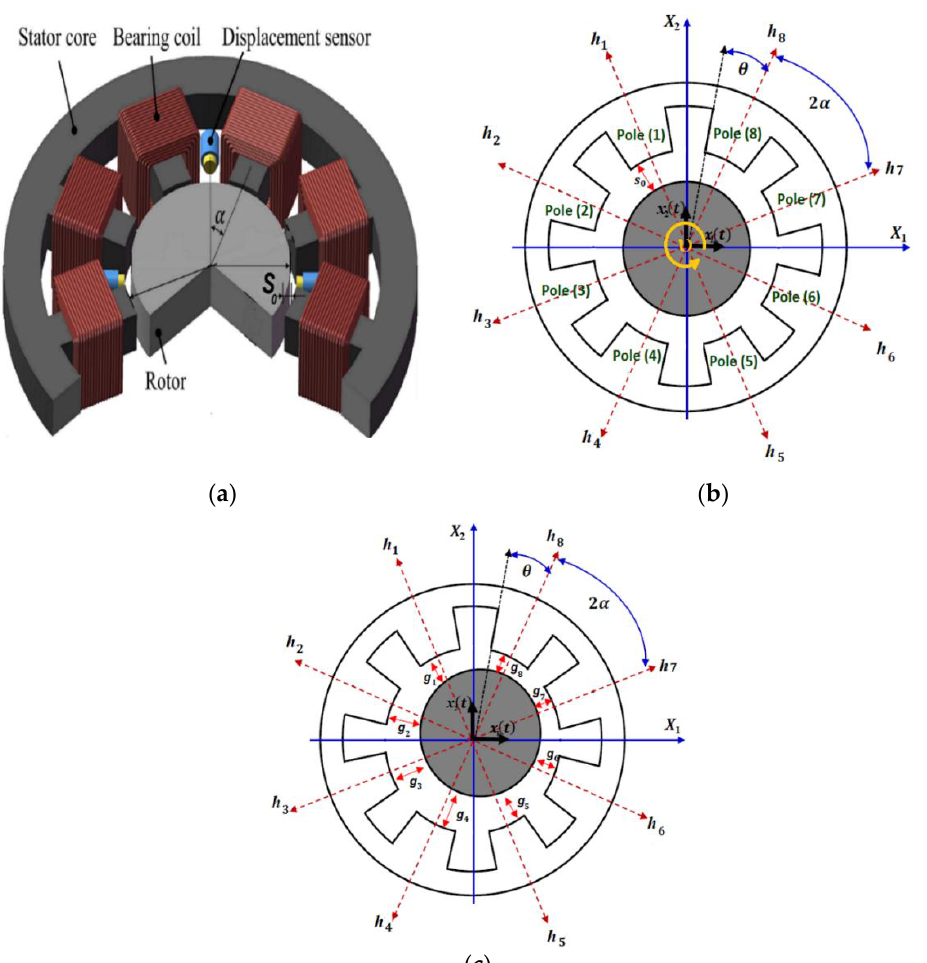
Figure 1. ( a ) The 3-D visualization of the eight-pole electro-magnetic suspension system, ( b ) schematic diagram of the eight-pole electro-magnetic suspension system when the rotor lies within its nominal position, ( c ) schematic diagram of the eight-pole electro-magnetic suspension system when the rotor makes displacements 𝑥 1 (𝑡) and 𝑥 2 (𝑡) in 𝑋 1 and 𝑋 2 directions, respectively.